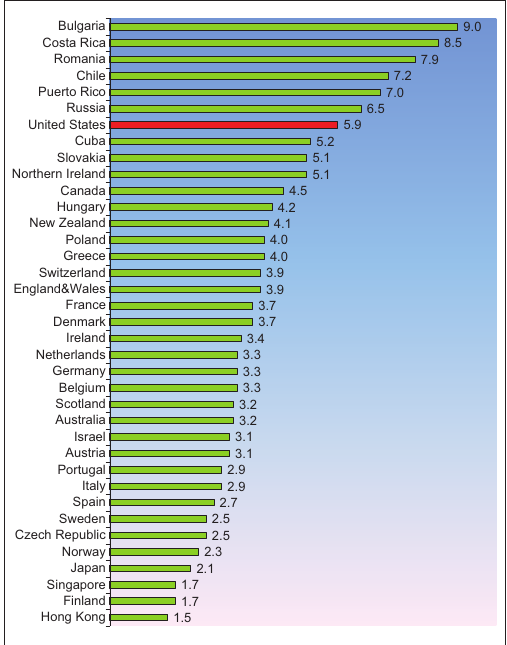
Figure 1 : Infant Mortality Rate (IMR) per 1,000 Live Births for Selected Countries, 2015 Source: WHO. OECD, Global Health Observatory and Official National Health Statistics for Selected Countries.